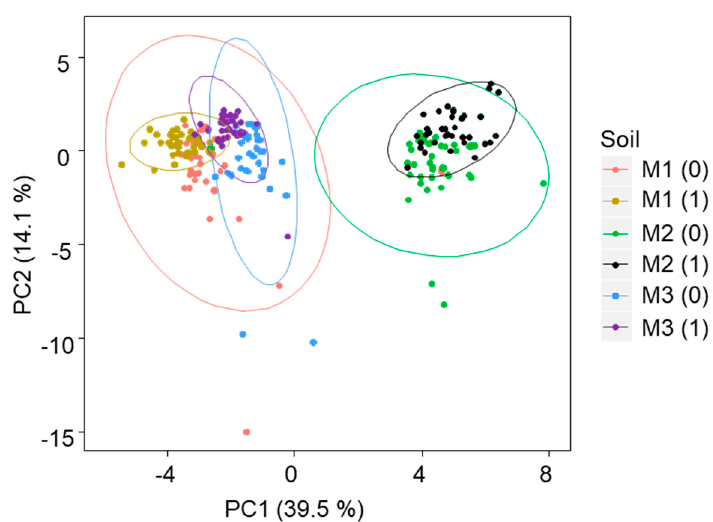
Figure 1. Principal component analysis of the phospholipid fatty acid analysis (PLFA) data of the different soil mixtures M1 (Soil mixture 1), M2 (Soil mixture 2) and M3 (Soil mixture 3), immediately after heating (0) and one month after the incubation period (1). The ellipses represent data intervals (95%).